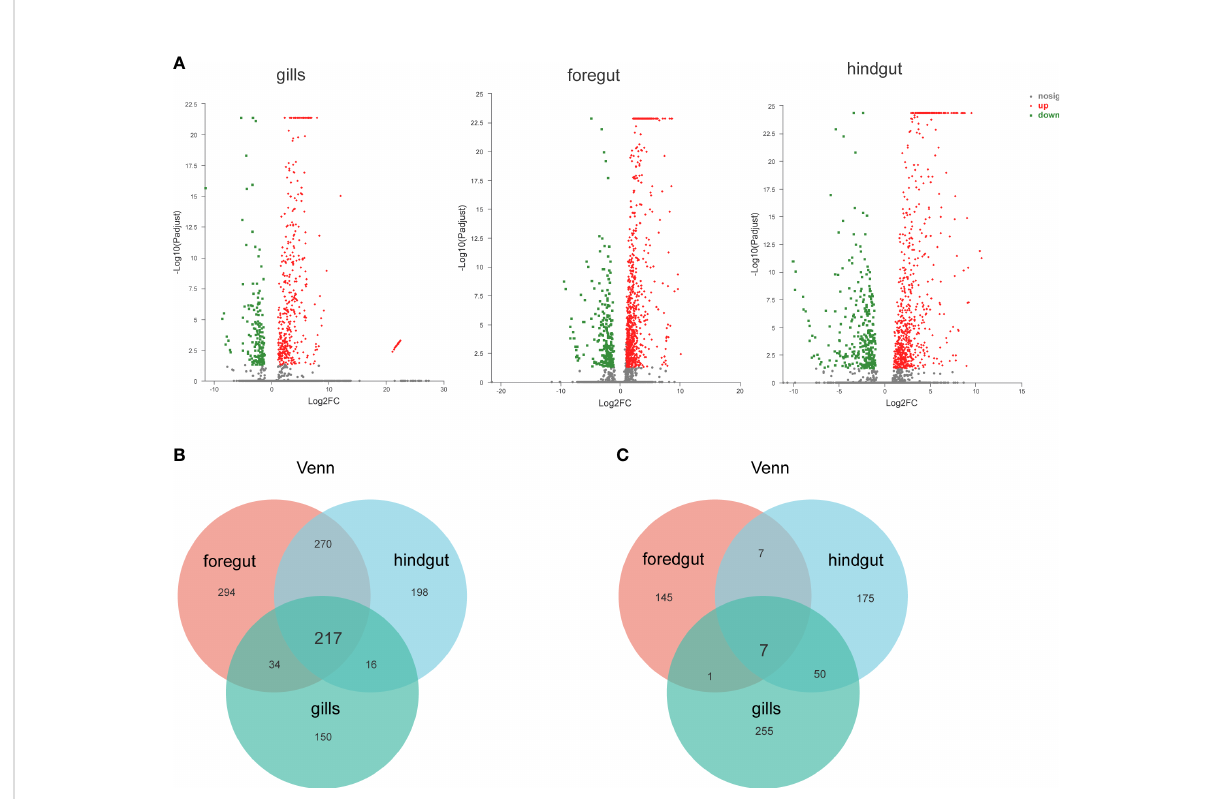
FIGURE 1 Identi fi cation and analysis of differentially expressed genes (DEGs). (A) Volcano plot of DEGs from the transcriptome in carp gills, foregut and hindgut between the control and spring viremia of carp virus (SVCV)-infected groups. (B) Venn diagrams representing the number of transcripts co-upregulated DEGs for each sample. (C) Venn diagrams representing the number of transcripts co-downregulated DEGs for each